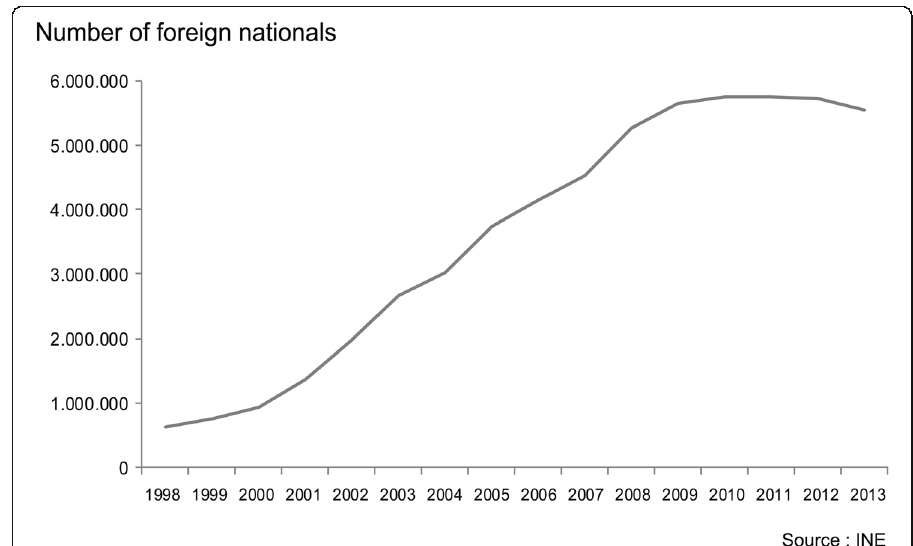
Fig. 1 Number of foreign nationals in Spain from 1998 to 2013